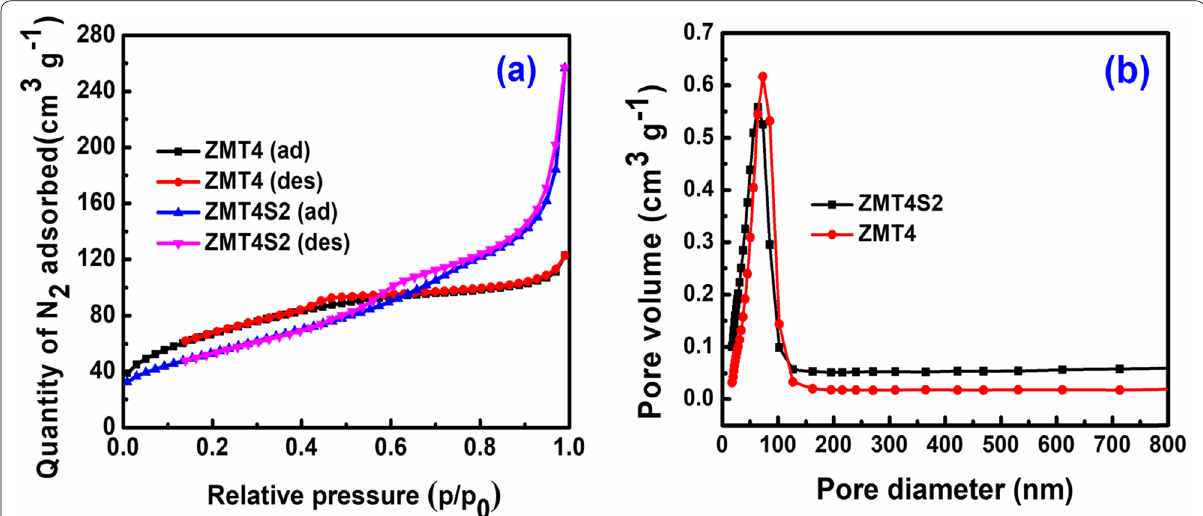
Fig. 6 a N 2 adsorption–desorption isotherms and b BJH pore size distribution curves of ZMT4 and